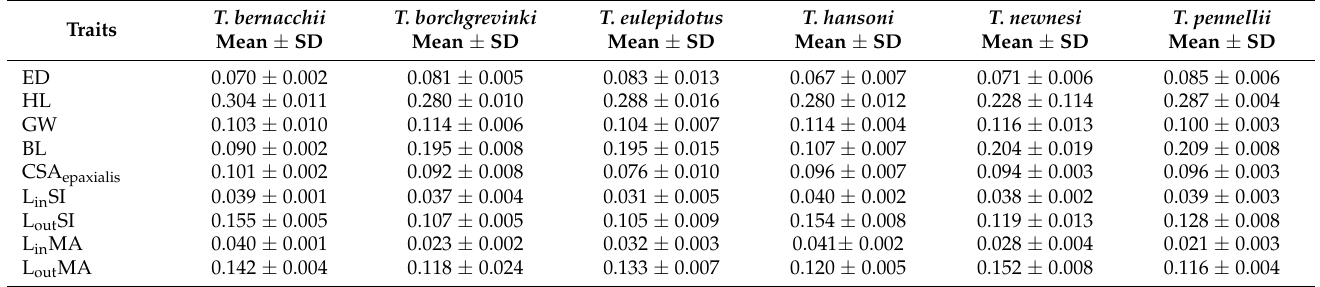
Table 3. Mean values and standard deviations of the 9 morphological traits. Measures were stan- dardized by SL. Traits: Eye diameter (ED); Head length (HL); Gape width (GW); Buccal length (BL); Cross-Sectional Area (CSA epaxialis ); In-lever Suction Index (L in SI); Out-lever Suction Index (L out SI); In-lever Mechanical Advantage (L in MA); Out-lever Mechanical Advantage (L out MA).